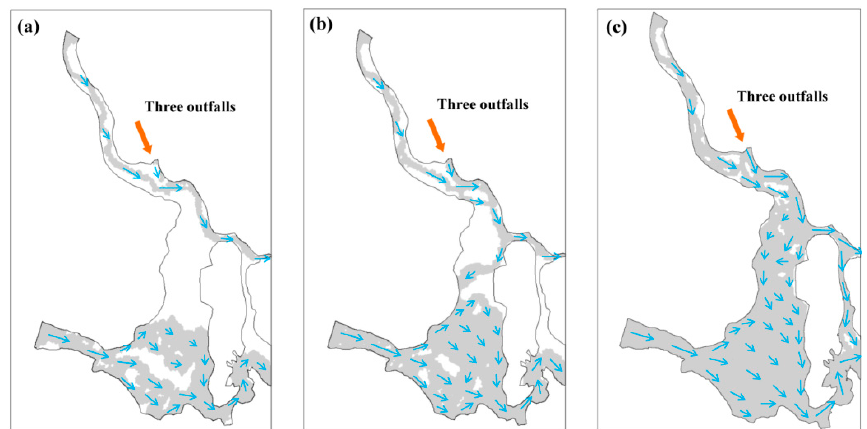
Figure 6. Hydrodynamic schematic diagram of West Dongting Lake and its inflow rivers in the three study periods. A two ‐ dimensional hydrodynamic model of Dongting Lake [39] was used to simulate the hydrodynamic diagram of West Dongting Lake and its inflow rivers. The gray areas represent the flow scope, the arrows “ → ” indicate the flow direction and the length of the arrow represent the flow velocity. From left to right, the periods are the dry season ( a ), the normal season ( b ), and the wet season ( c ).